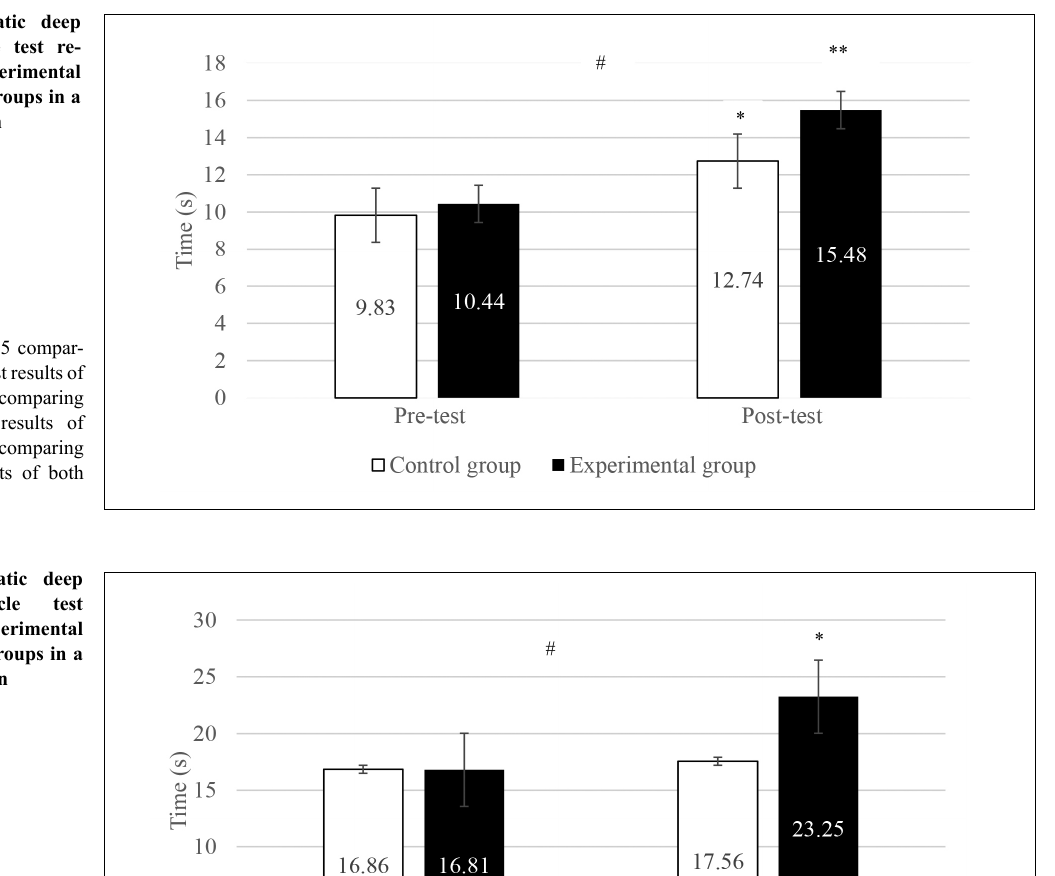
Figure 1. Static deep trunk muscle test re - sults of experimental and control groups in a prone